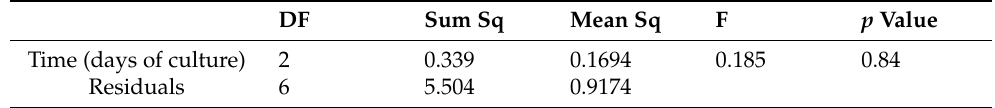
Figure 2. Daily growth rate (DGR, % d − 1 ) of Gracilaria chilensis biomass during 21 days of culture. Error bars indicate standard deviation. There were no significant differences between the averages according to the analysis of variance ( p > 0.05). Table 3. Results of one-way ANOVA for culture time (days) and daily growth rate (DGR, % d − 1 ) of Gracilaria chilensis biomass under the proposed